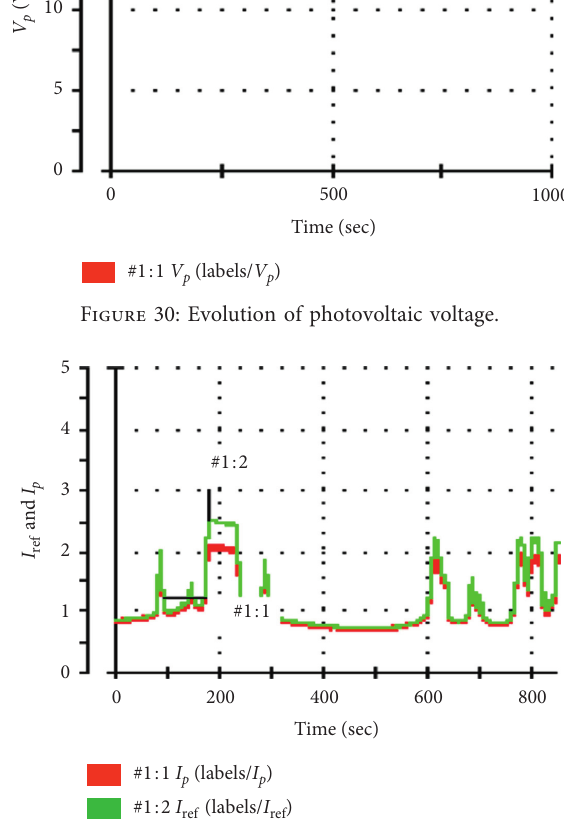
Figure 31: Evolution of I